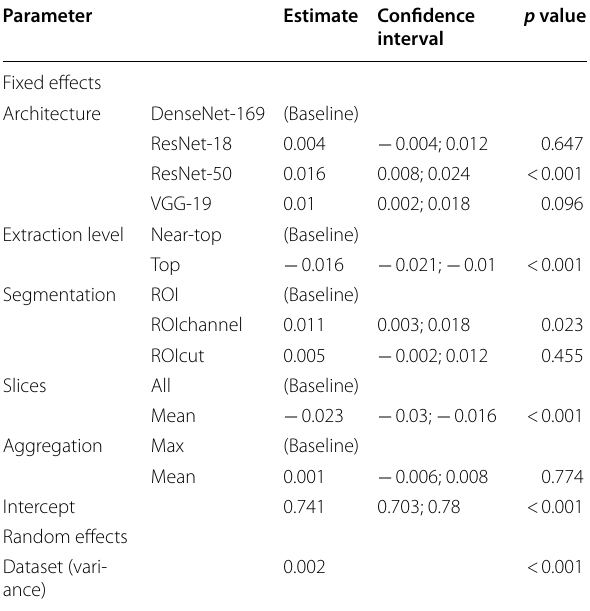
Table 5 Results of the mixed linear model